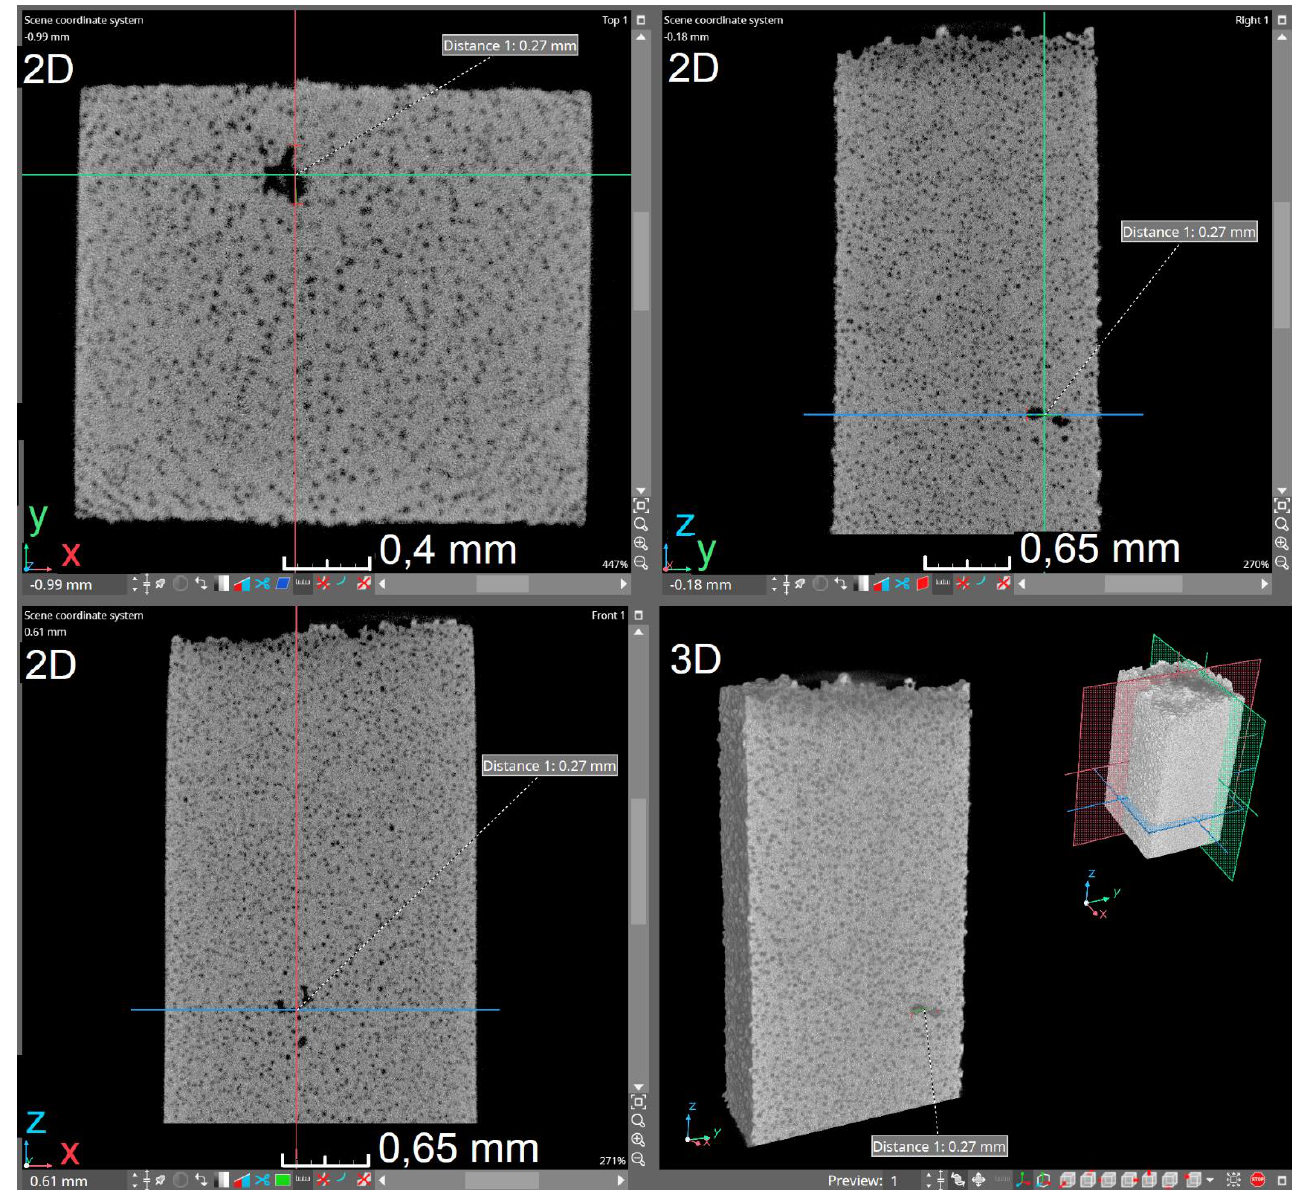
Figure 5. The VGStudio Max software dialog box showing: selected 2D cross-sections (in the xy, yz, and xz plane); 3D spatial section with marked location of section planes. The image shows spheroidal graphite, additionally dimensioning the selected internal discontinuity.